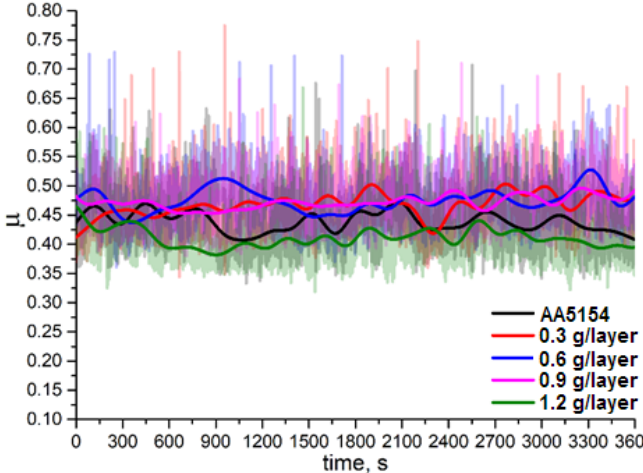
Figure 14. Coefficient of friction vs. time dependencies of samples.